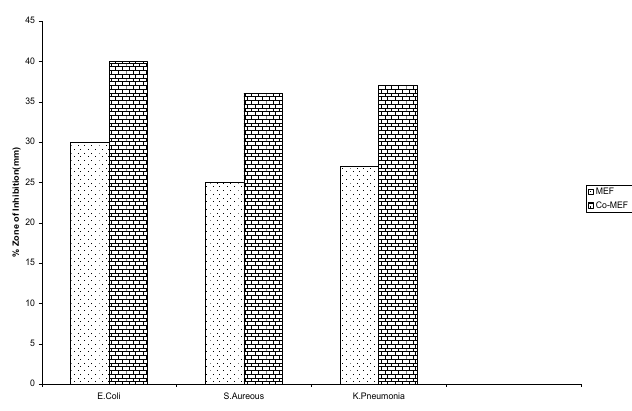
Figure 1. Inhibitory activity of the ligands and metal complexes against Escherichia coli; Staphylococcus aureus, and Klebsiella pneumonia.